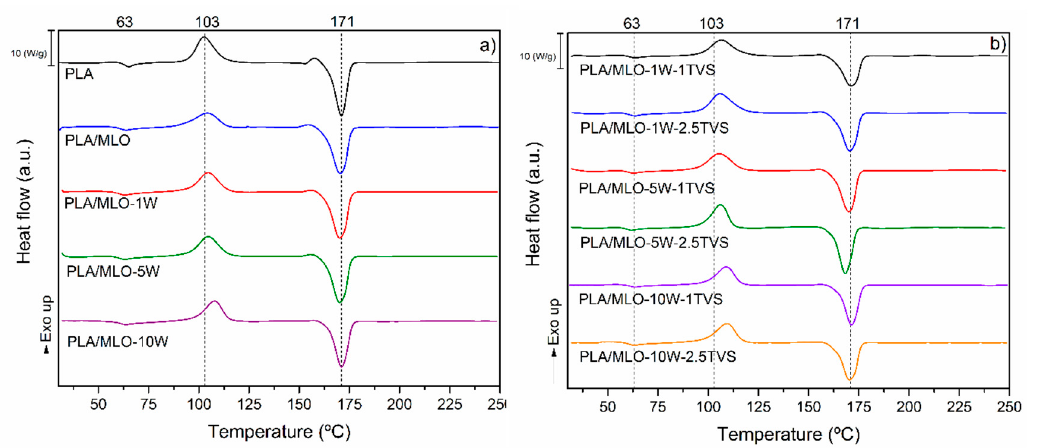
Figure 9. Second heating DSC curves of ( a ) untreated wool composites and ( b ) wool treated with TVS composites.